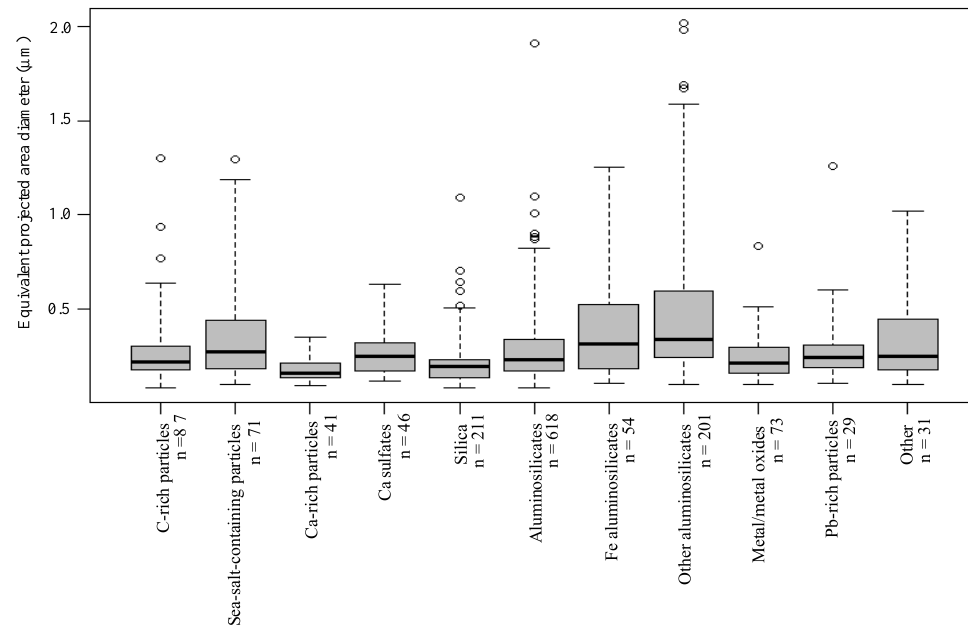
Figure 7. Size of IRs. Three outliers of other aluminosilicates are shown (2.7, 2.9, and